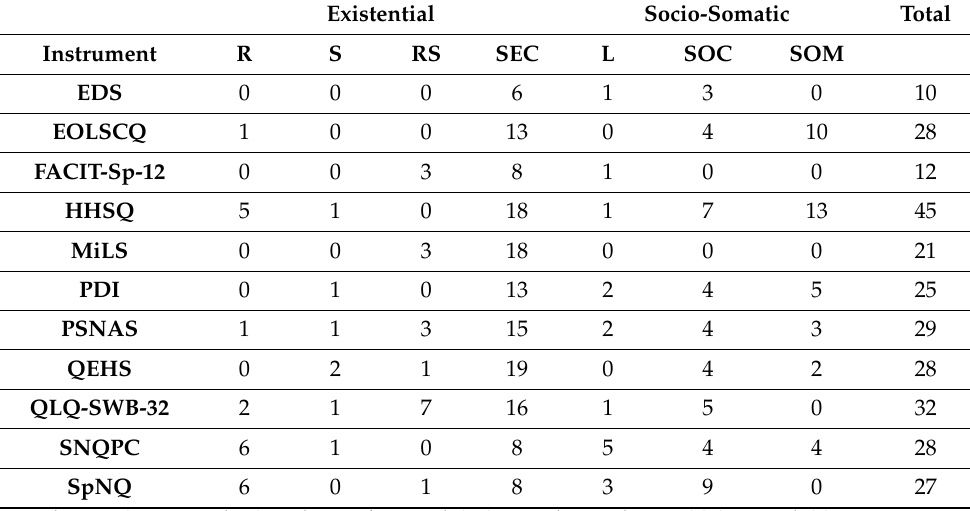
Table 4. Existential and socio-somatic sub-domains.